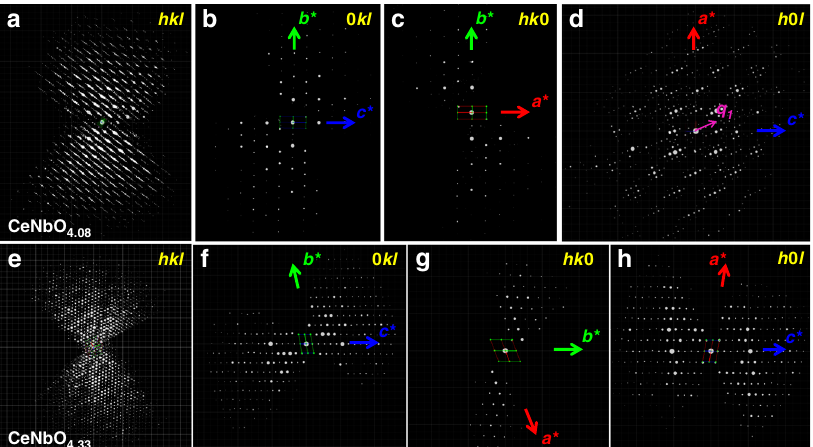
Fig. 2 3D ED data of CeNbO 4.08 and CeNbO 4.33 . 3D reciprocal lattice reconstructed from the 3D ED data of CeNbO 4.08 ( a ) and CeNbO 4.33 ( e ). b ( 0kl ), c ( hk0 ), and d ( h0l ) slices extracted from the reconstructed reciprocal lattice of CeNbO 4.08 , re fl ection conditions: 0 klm : k + l = 2 n . hk0m : h + k = 2 n , h0lm : h + m = 2 n , l + m = 2 n , h00m : h + m = 2 n , 0 k00 : k = 2 n , 00 lm : l + m = 2 n . f ( 0kl ), g ( hk0 ), and h ( h0l ) slices cut from the reconstructed reciprocal lattice of CeNbO 4.33 , re fl ection conditions: no special systematic re fl ections appear forbidden.